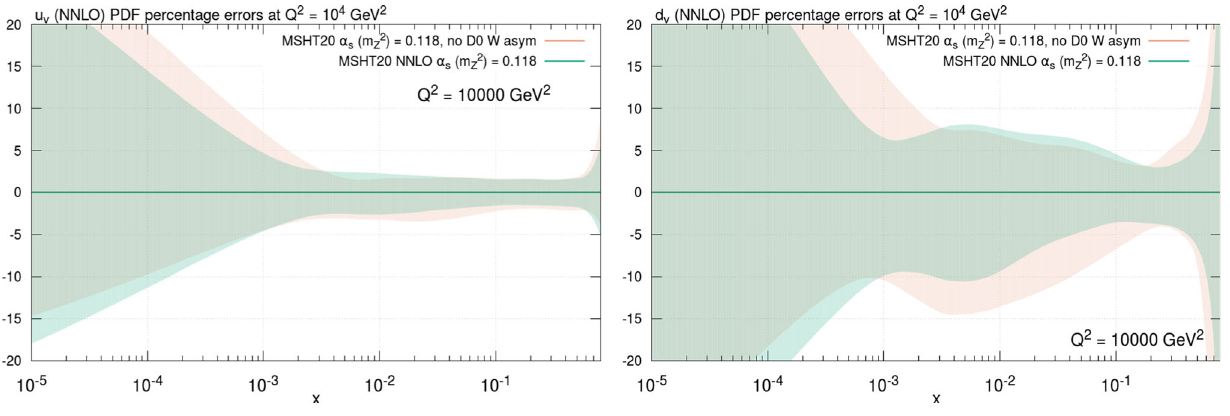
Fig. 60 (Left) u V and (right) d V PDF percentage errors at Q 2 = 10 4 GeV 2 at NNLO in both the MSHT20 default fit and the same with the removal of the DØ W asymmetry data, and without fitting the electron